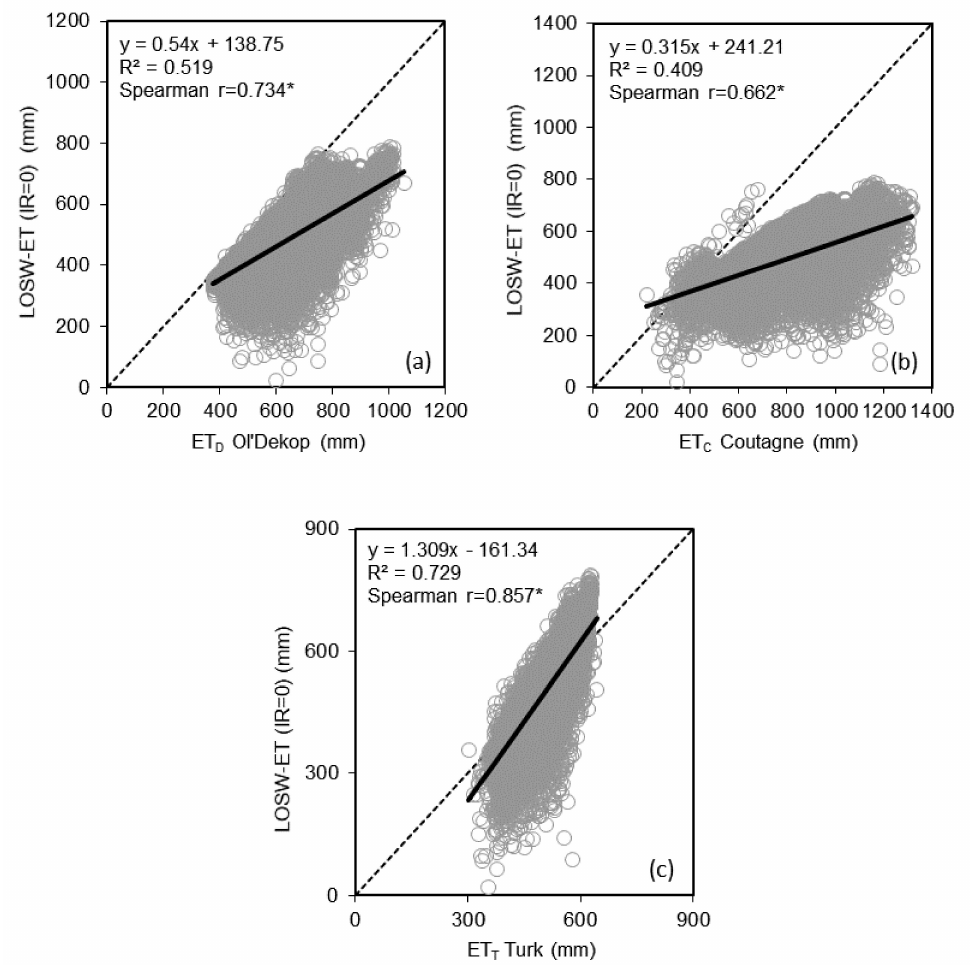
Figure 5. 1:1 plots between mean annual actual evapotranspiration of LOSW-ET ( IR = 0) versus ( a ) ET D Oldekop, ( b ) ET C Coutagne and ( c ) ET T Turk for the period 1950–2000 (15% of random data selection and exclusion of regions with K s =